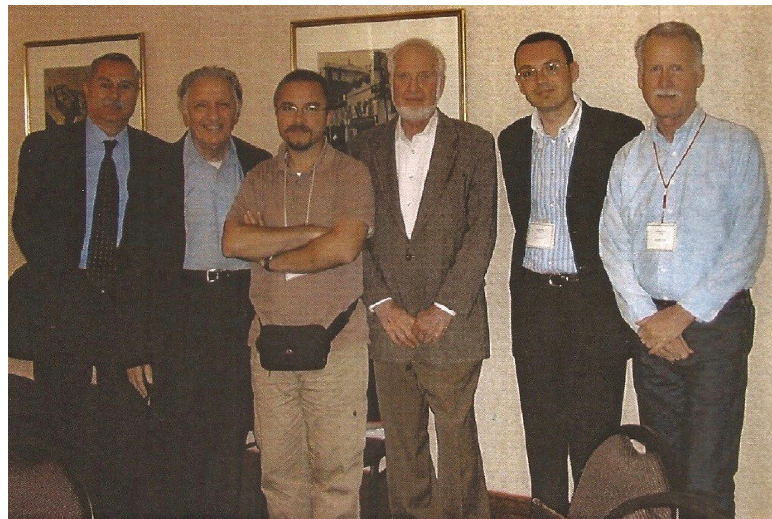
Figure 2: Photograph taken during the DeMoSTAFI meeting held in Québec, Canada, May 20–22, 2004. From left to right: Carlo Sempi, Abe Sklar, Gianfausto Salvadori, Berthold Schweizer, Fabrizio Durante, and Roger